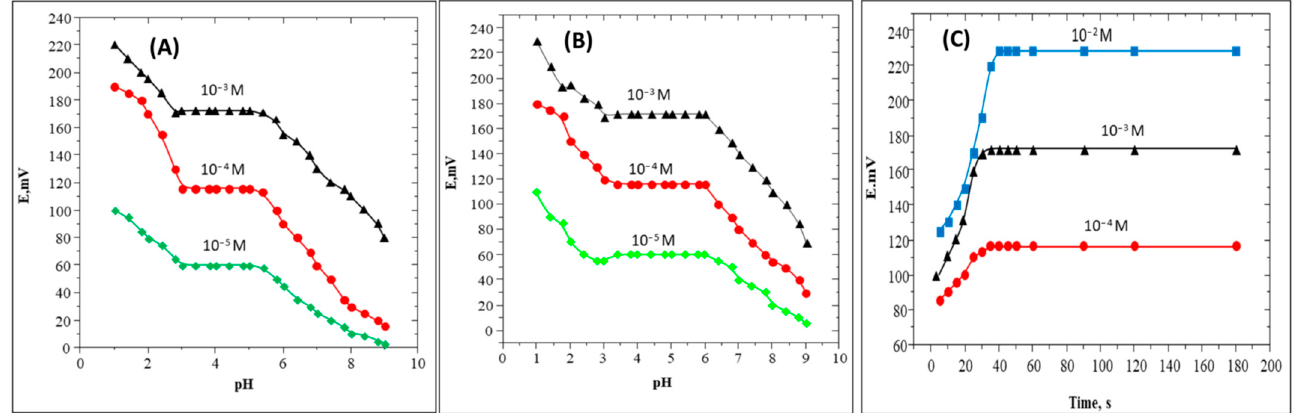
Figure 3. ( A – C ): The effect of pH on O- NPOE plasticized PVC electrodes containing the ( A ) SC-TPB and ( B ) SC-PTA on SC sensing, while ( C ) shows the average dynamic response time of the SC-TPB sensor electrode towards SC.